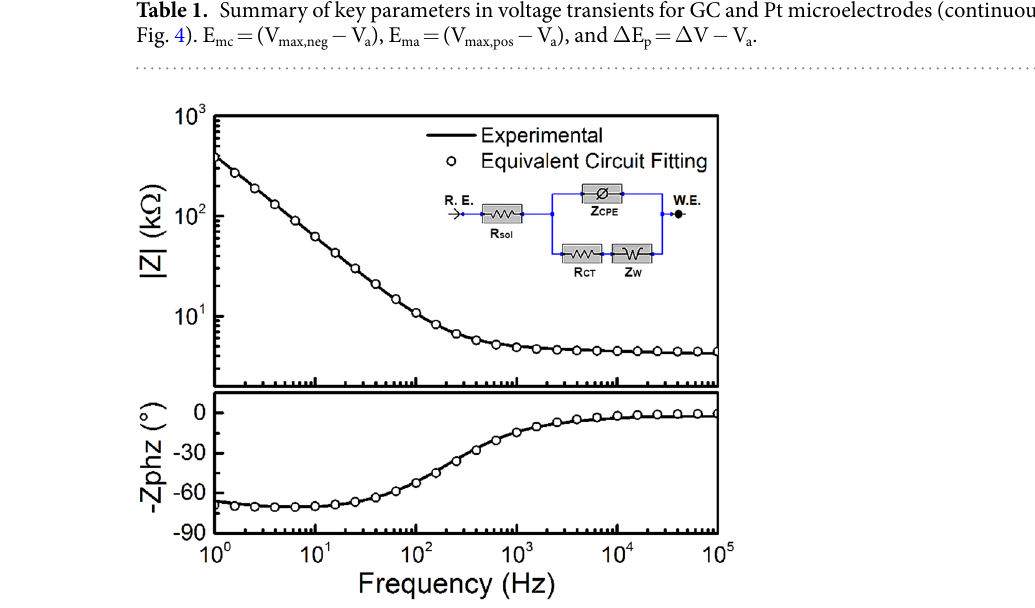
Figure 5. Equivalent circuit for aGC microelectrode based on modified Randles model. Representative EIS impedance spectra for experimental data (solid line) and equivalent circuit fitting (circles) used for curve fitting are shown. The optimal equivalent circuit model used (modified Randles circuit) is shown in inset. It is composed of electrolyte resistance (R sol ) in series with a parallel combination of constant phase element (Z CPE ), Warburg diffusion impedance (Z W ), and charge transfer resistance (R ct ). The EIS parameters obtained through fitting the experimental data to the model are: R sol = 4.4 kΩ, Z CPE with Y 0 = 4.07 e − 11 S * s α and α =